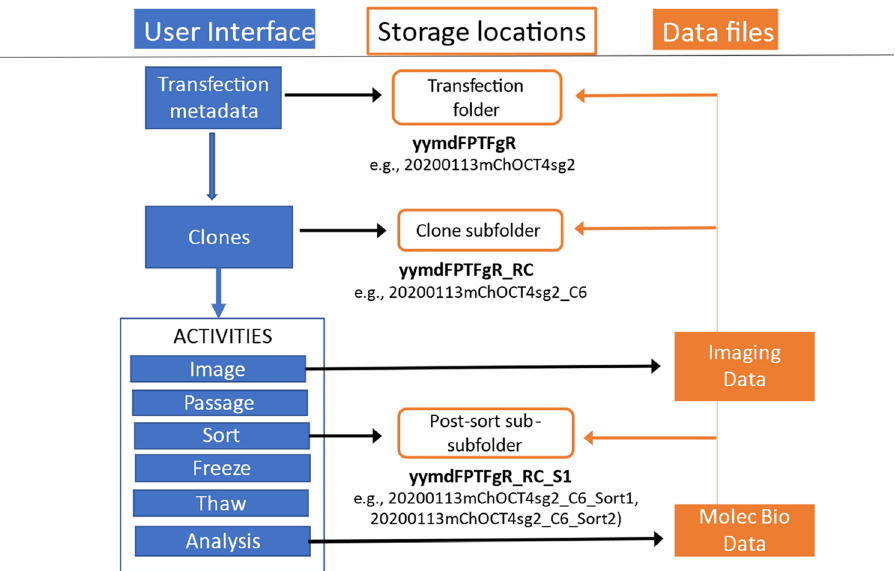
Figure 3. Schematic of the data model and naming convention. Various activities were performed on each cell sample. Initiating a transfection resulting in generating a unique transfection designator, or cell sample name, which served as the base name for subsequently derived cell samples. Updated cell sample names were created by appending terms to the transfection designator to indicate activities performed on the sample. Using a cell sample-naming convention, storage location folders were automatically generated with those unique sample designators, providing a local persistent identifier and an organizational structure for storing related sample- specific data. In this naming convention, FP represents fluorescent protein, TF represents transcription factor, and gR represents guide RNA. Row “R” and column “C” locations in 96-well plates where edited cells were observed (e.g. “_C6”) provided an appended designator for that cell sample that was isolated and further acted on. Flow cytometry sorting was used to enrich and expand populations of edited cells, which were indicated